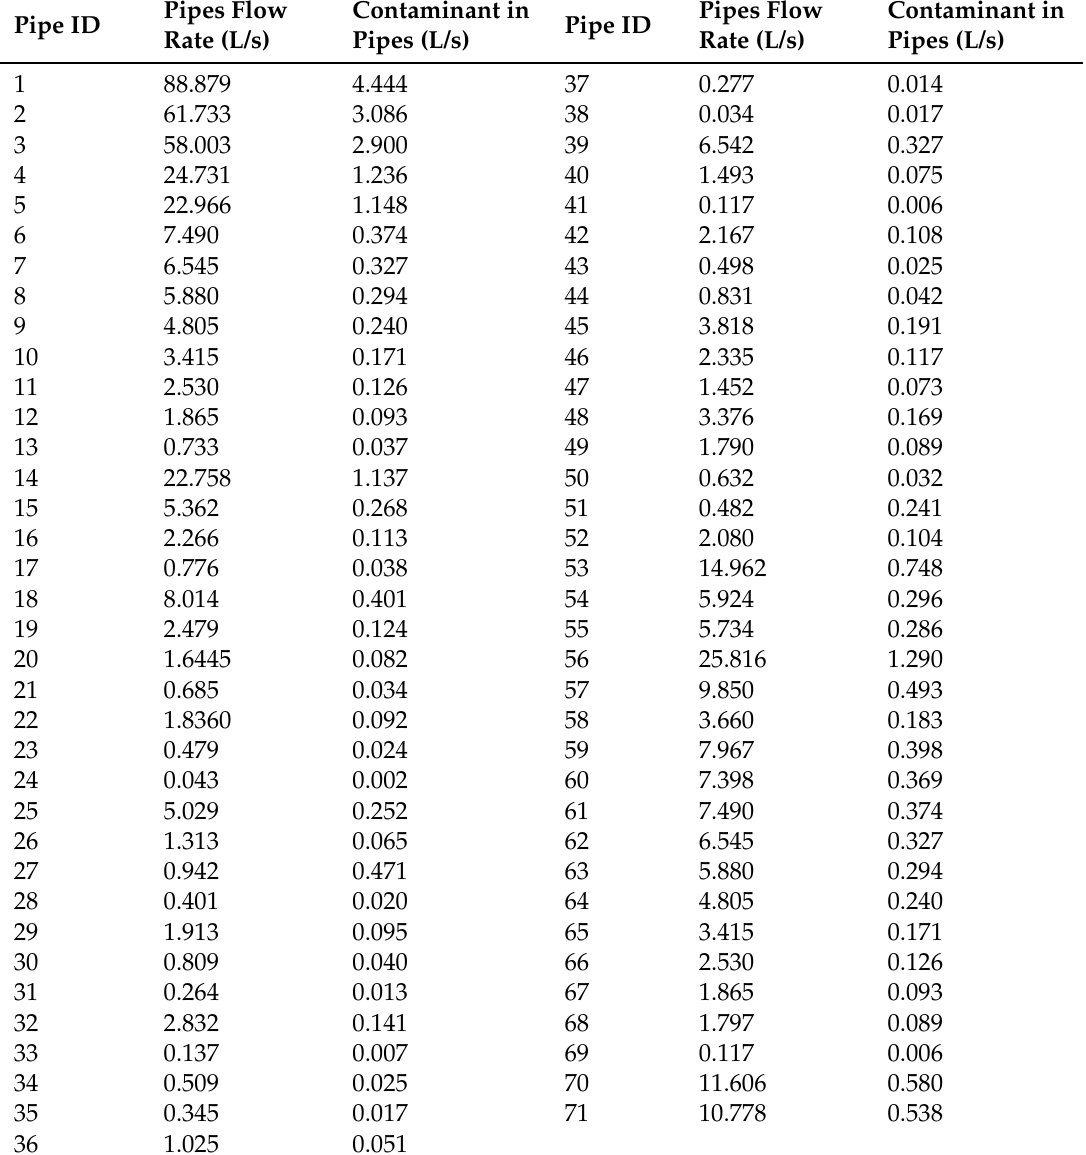
Table 4. Numerical results for pipe and contaminant flow for Illustrative Example